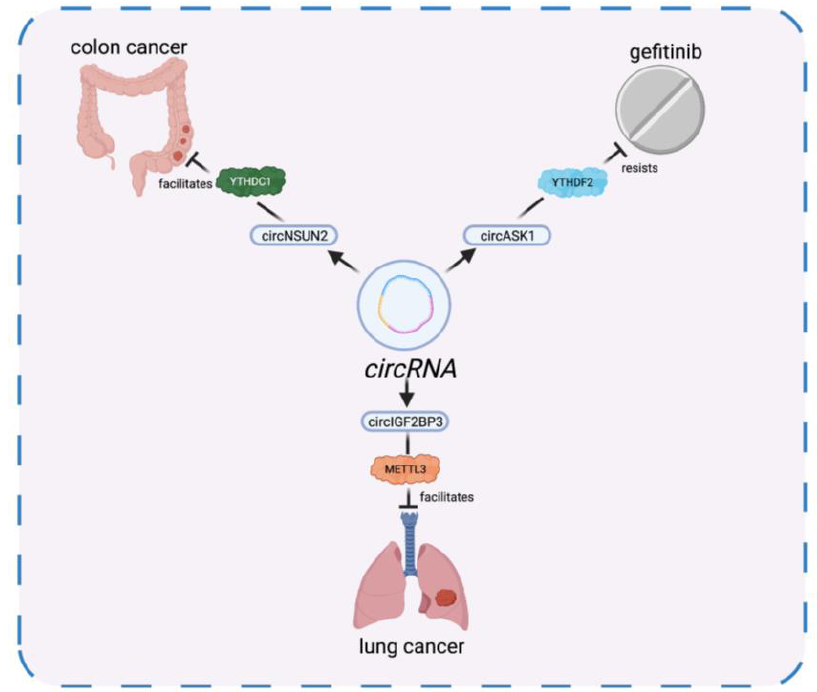
Figure 3. The interaction between circRNA and its m6A regulators.